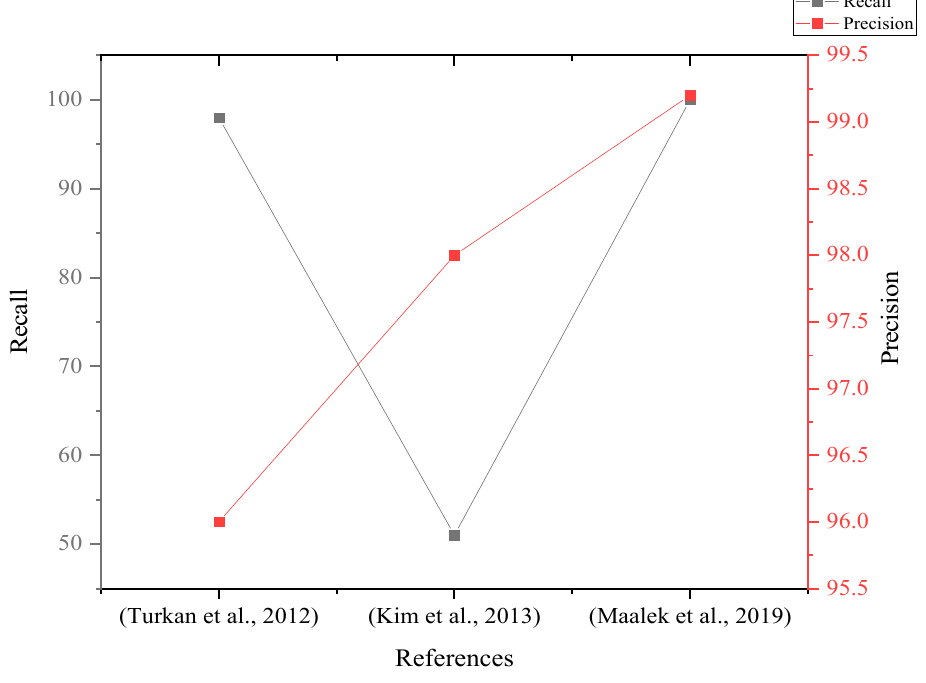
Figure 4. Recall and precision (%) of laser scanning studies [10,56,63] for construction progress monitoring.